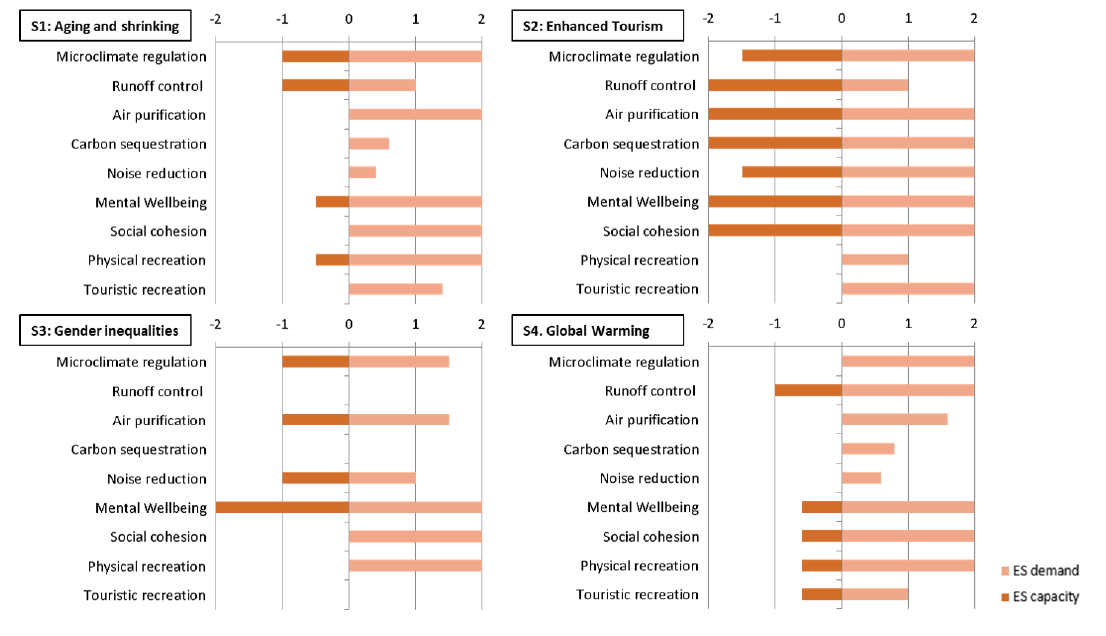
Fig. 3. Assessment of the ecosystem services (ES) capacity and demand gaps in the four scenarios (S1 to S4). The darker shading indicates a decreasing trend in ES capacity (–1 = moderate decrease; –2 = substantial decrease), whereas the lighter shading indicates increasing demand for ES (+1 = moderate increase; +2 = substantial increase). The colored bars are averaged values from the ES assessment exercise, which highlight the majority of the respondents’ opinions when consensus was not reached. Values equal to zero correspond to no changes in the ES capacity and demand